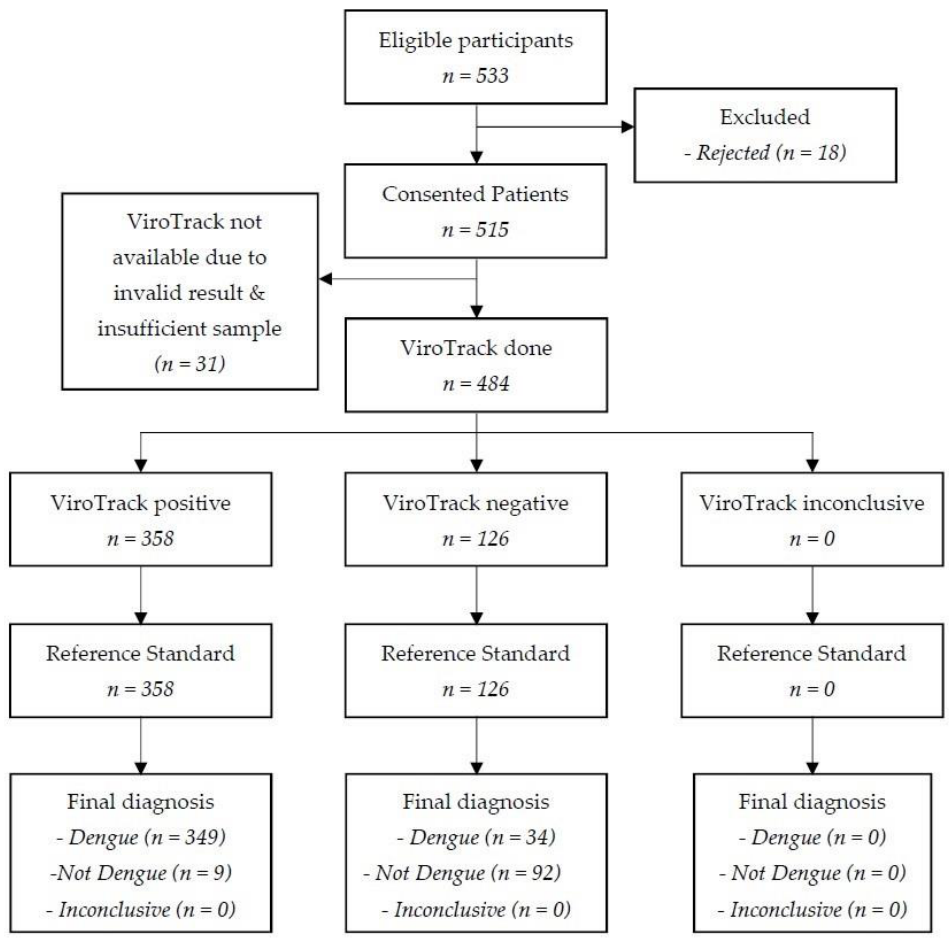
Figure 2. STARD flow diagram for the evaluation of ViroTrack Dengue Serostate. The age of these 484 participants ranged from 1.0 to 83.7 years, and averaged at 32.0 (s.d. 18.4) years. There were 250 (51.7%) male participants. The majority were of Malay ethnicity (373, 77.1%), followed by Indian descent (52, 10.7%,) and Chinese descent (31, 6.4%), while 8 (1.7%) people were natives of East Malaysia and 20 (4.1%) were foreigners (data not shown).